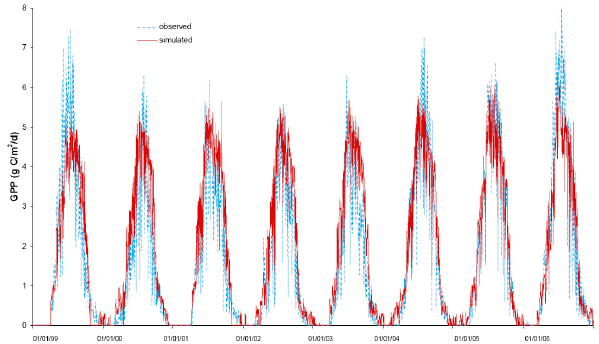
Fig. 1. The time series of hourly measured (blue dashed line) and simulated (red solid line) GPP for 1999–2006.